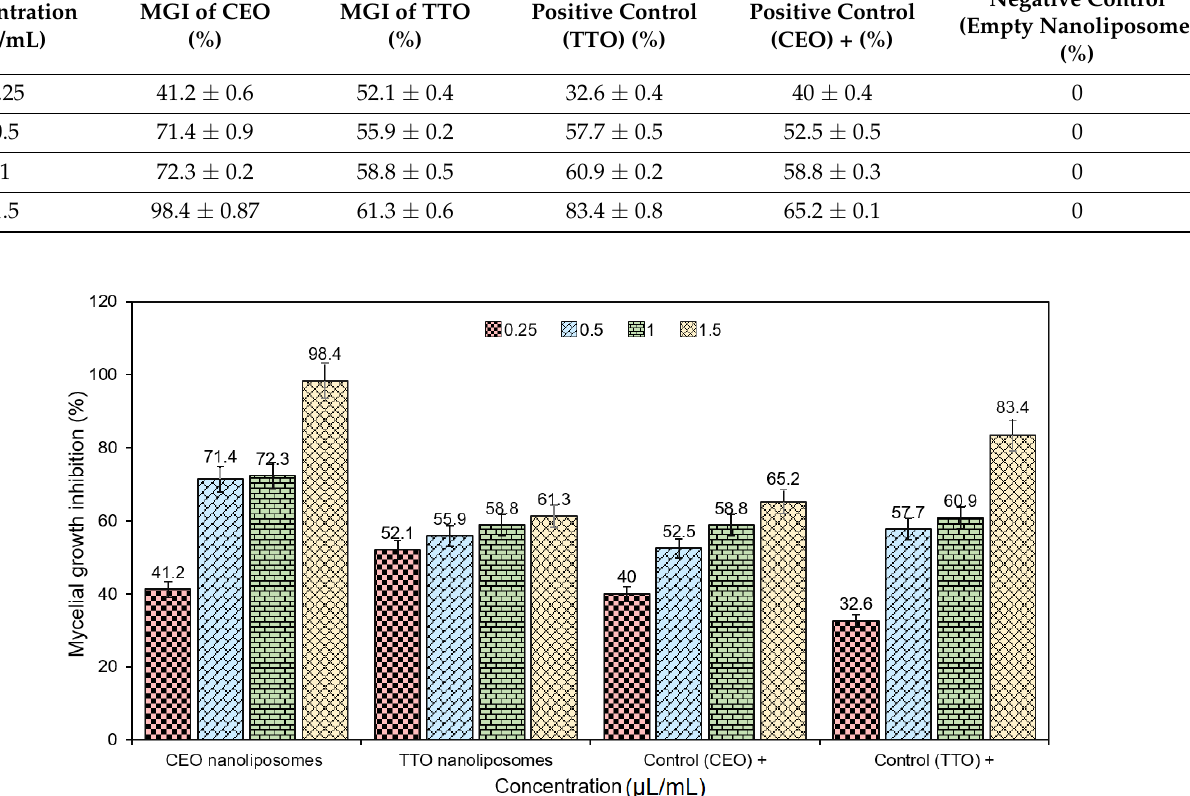
Table 5. Mycelial growth inhibition (MGI) of CEO and TTO nanoliposomes. Pure CEO and TTO were positive controls and empty nanoliposomes were negative control. Data were articulated as mean values ± standard deviation .